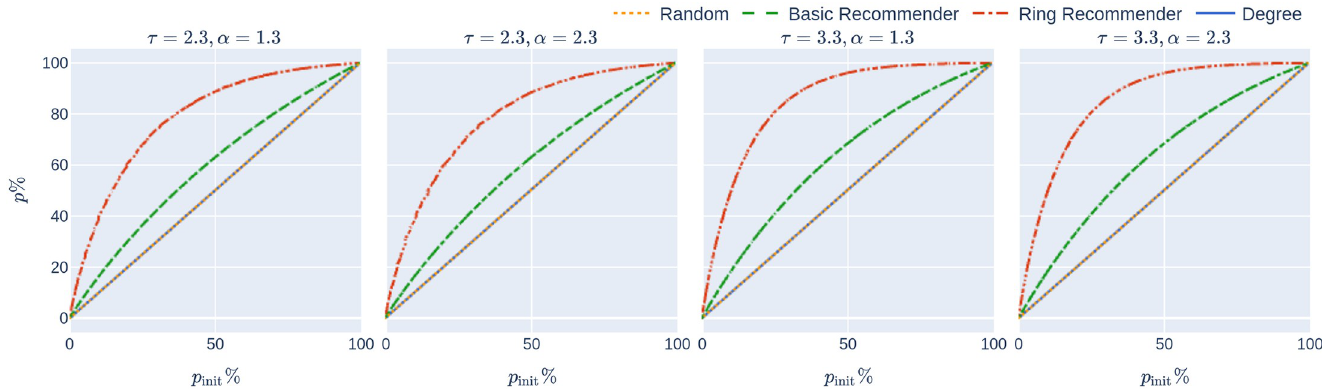
Fig 1. The initial app uptake p init % in relation to the final app uptake p % on four networks and the different uptake scenarios. The curves for random uptake degree-targetted uptake coincide and are straight lines, since it holds that p % = p init %, while for recommender scenarios p % > p init %. Increasing p % increases the probability that a node is recommended by multiple persons, explaining the concave curves corresponding to the recommender scenarios.